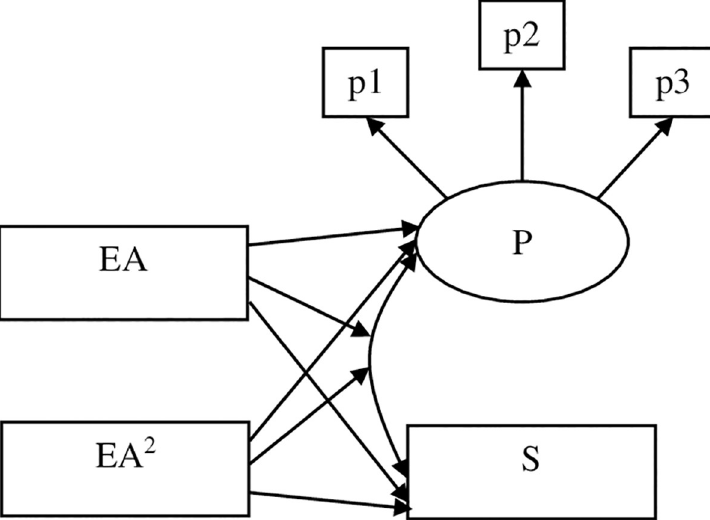
Fig 2. The conceptual diagram for the test of the linear and quadratic moderating effects of early adversity on the covariance between adulthood stressor exposure and personality traits. P = personality traits; S = stressor exposure; EA = early adversity; p1-p3 represents manifest indicators of personality.